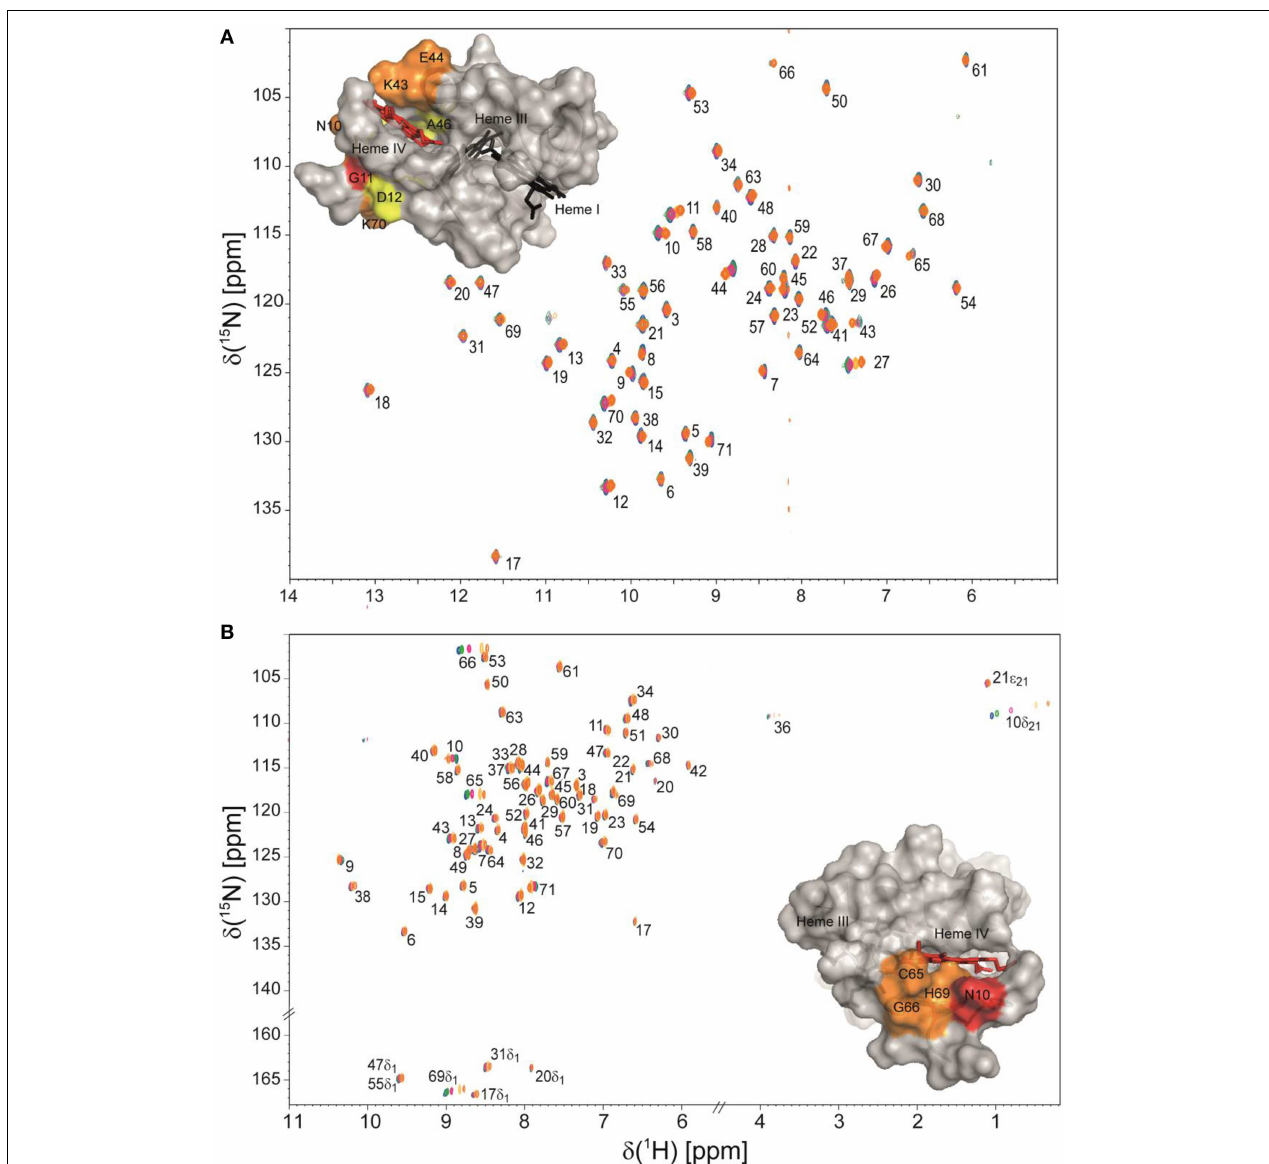
surface map of significantly perturbed residues in PpcA (PDB code, 2LDO, Morgado et al., 2012b) upon binding of AQDS. The chemical shift perturbation increases from yellow (small) to red (large). Heme IV is shown in red and hemes I and III are shown in black. The molecular surfaces were generated in PyMOL (Wl,